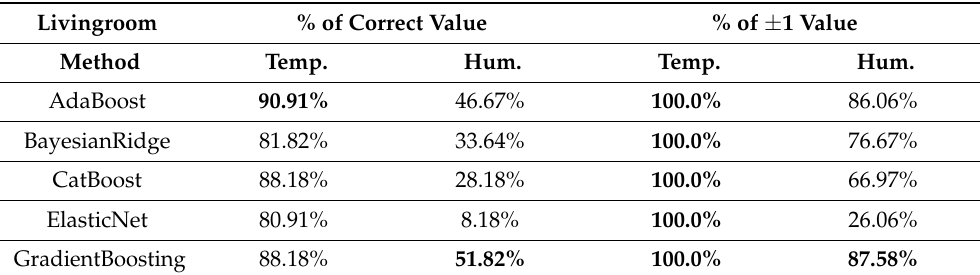
Table 6. Evaluation of algorithms for the measurements bedroom-living